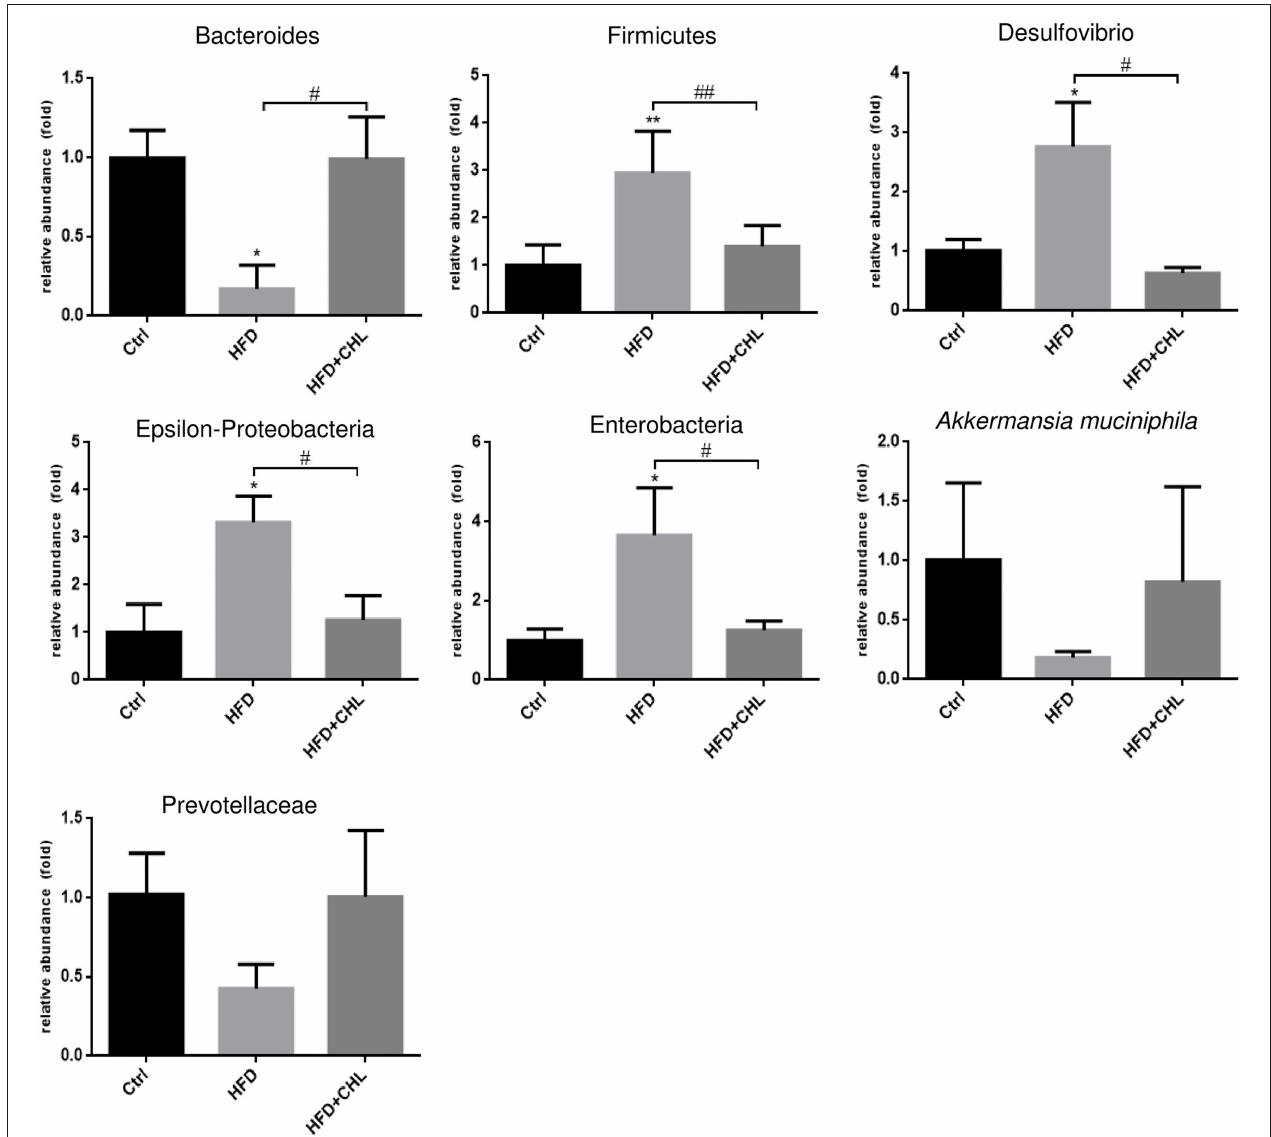
FIGURE 7 | Chlorophyllin (CHL) balances the gut microbiome of the mice fed with an HFD. Fresh fecal pellets were collected for extraction of bacteria DNA. Specific microbes, including Bacteroides, Firmicutes, Desulfovibrio, Epsilon-Proteobacteria, Enterobacteria, Akkermansia muciniphila , were determined by qPCR as mentioned in the section, Materials and methods and n = 6–8 for each group. Values are mean ± SEM; * p < 0.05, ** p < 0.01 vs. Ctrl group; # p < 0.05, ## p < 0.01 vs. HFD group.